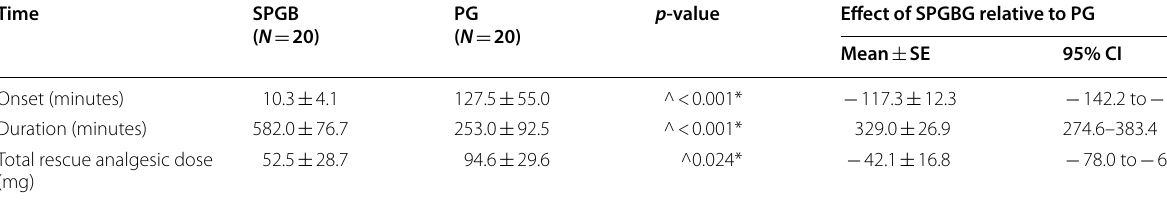
Data expresses as n (%)